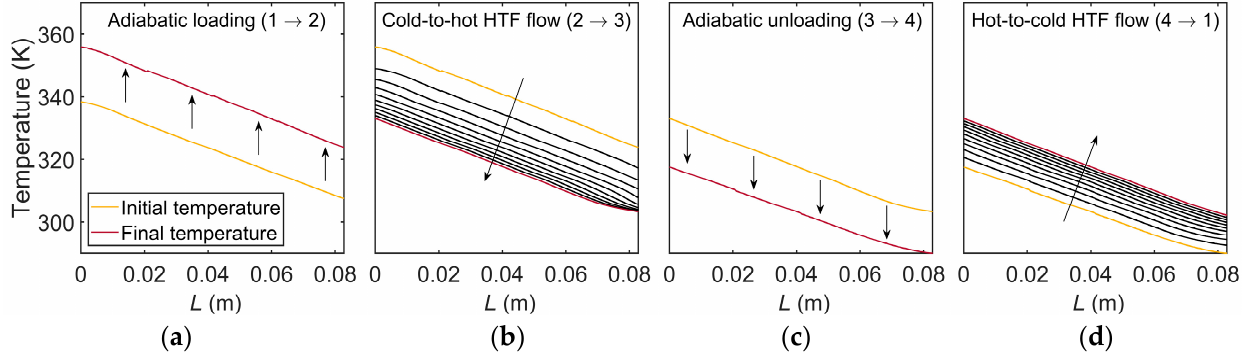
Figure 6. Evolution of the eCM temperature profile along the AeCR during each phase of the thermodynamic cycle.